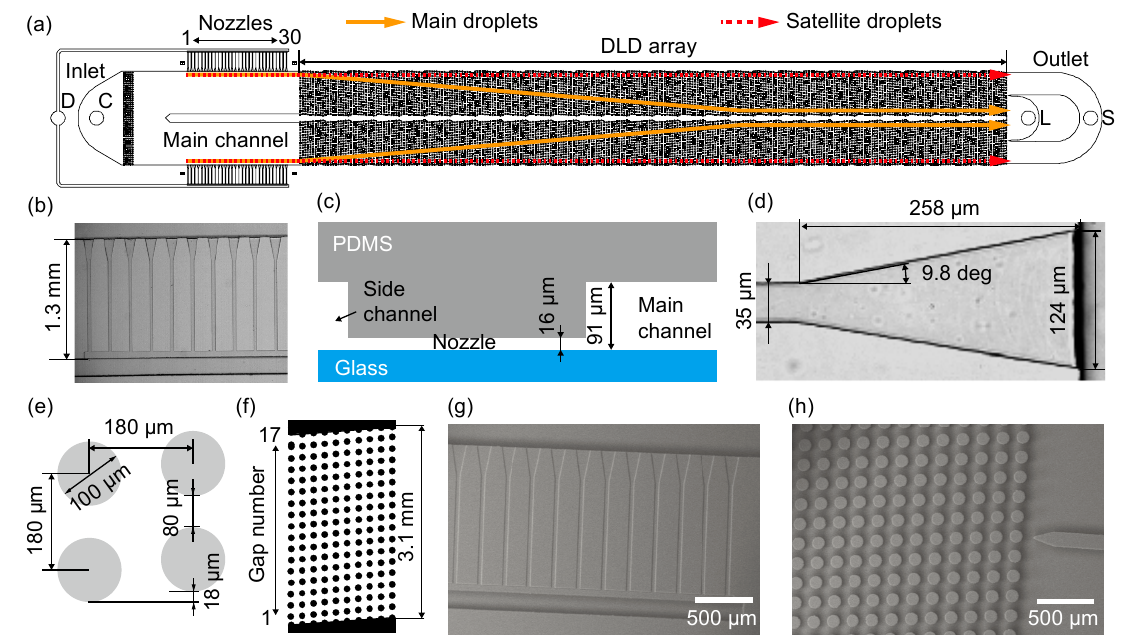
Figure 1. A microfluidic device comprising step-emulsification nozzles and deterministic lateral displacement (DLD) pillars for separating main and satellite droplets. ( a ) Schematic illustration of the top view of the device. ( b ) A photomicrograph of the nozzles. ( c ) A schematic cross-section of a nozzle connecting the side and main channels. ( d ) A photomicrograph of a triangular end of a nozzle. ( e ) A rhombic unit of the DLD pillars. ( f ) A single region containing the 10-column DLD pillars. ( g , h ) SEM images of the ( g ) nozzles and ( h ) pillars.